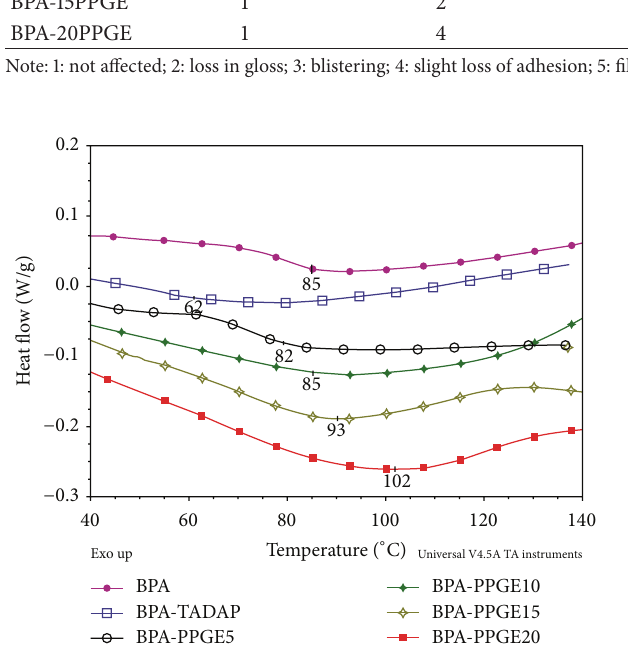
Figure 7: The DSC curves of epoxy-PPGE films in nitrogen at 10 ∘ (C/min) heating rate.